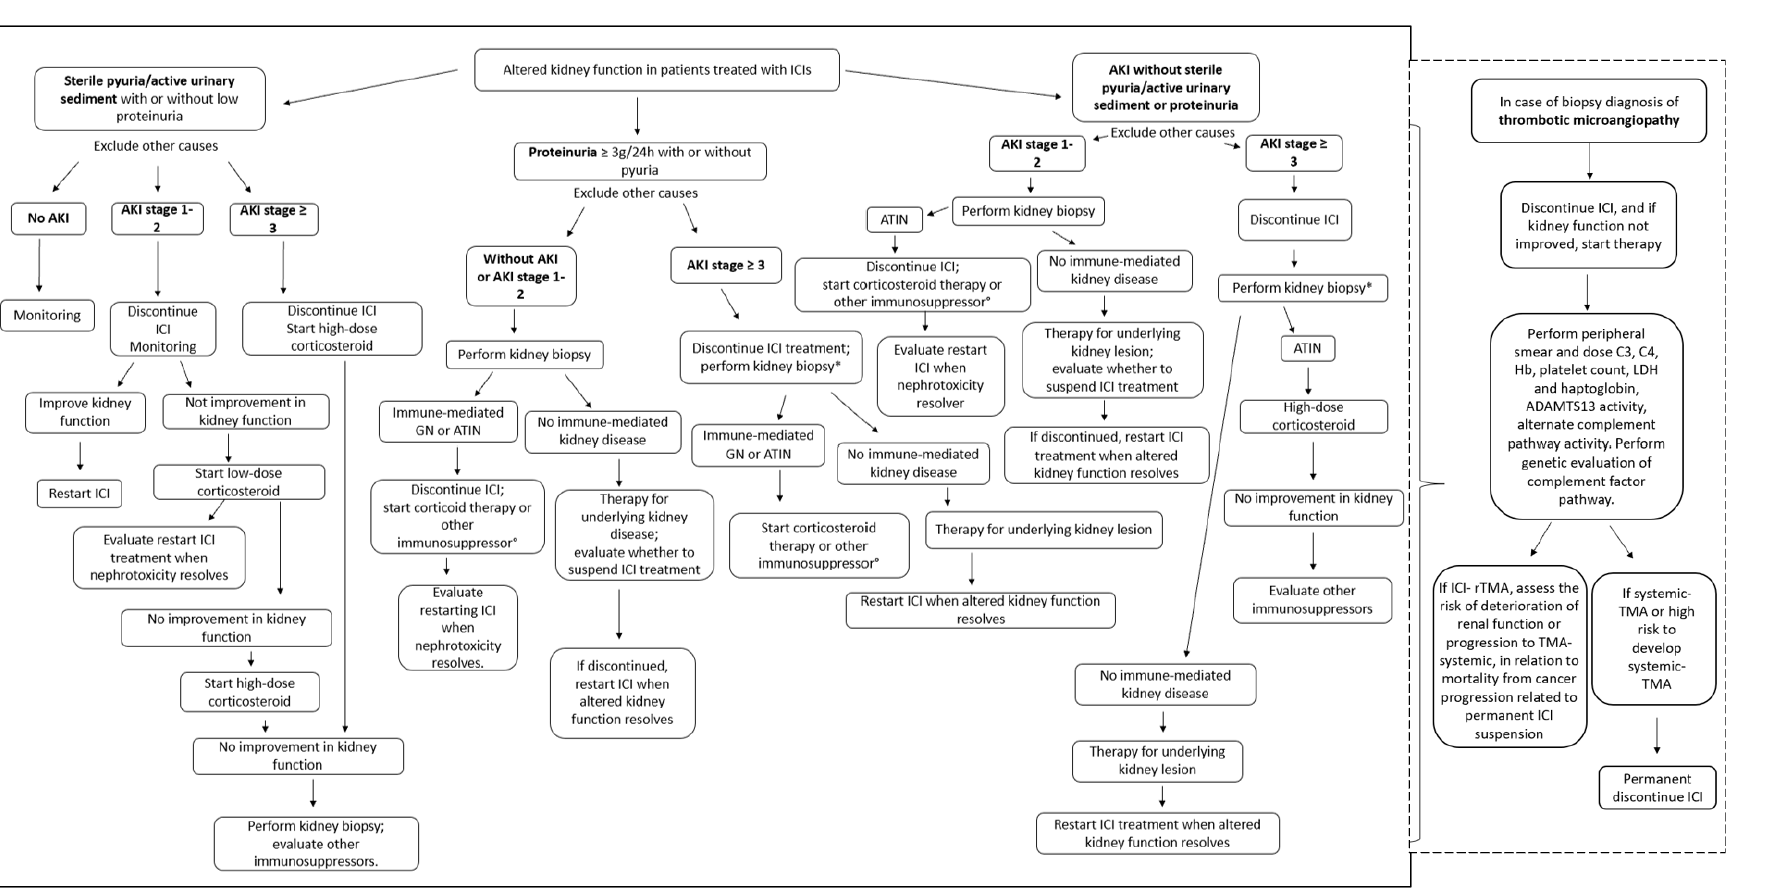
Figure 4. ICI-AKI management. Legend: *, within 48 h, if not possible, start corticosteroid therapy; ◦ , if there is no improvement in kidney function; AKI, acute kidney injury; ATIN, acute tubular-interstitial nephritis; GN, glomerulonephritis; ICI immune checkpoint inhibitor; C3, complement C3; C4, complement C4; Hb, hemoglobin; LDH, lactate dehydrogenase; ICI- rTMA immune checkpoint inhibitor- renal thrombotic microangiopathy.